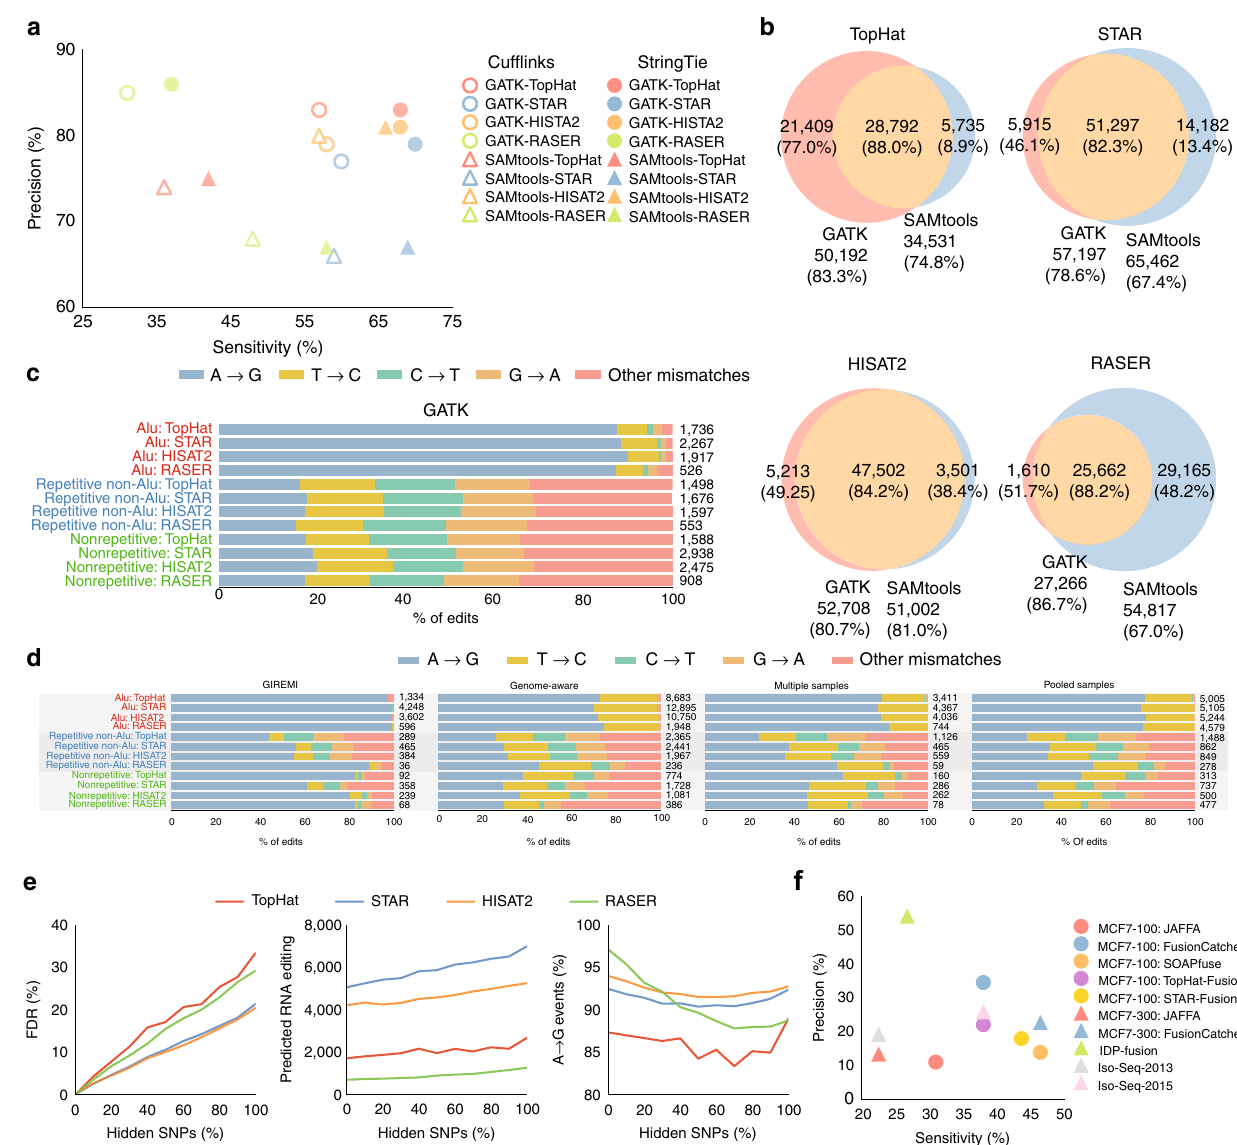
Fig. 7 Performance of different variant calling ( a – c ) RNA editing ( d , e ) and RNA fusion ( f ) detection approaches. a Accuracy of detecting NA12878 high- con fi dence calls in NIST gold standard. The analysis is restricted to the expressed exons identi fi ed by Cuf fl inks or StringTie. b Overlap between variants predicted by GATK and SAMtools. c Distribution of the predicted mismatch types by GATK that are missed in NIST HC calls (in StringTie ’ s expressed exons) in different genomic regions. d Distribution of RNA editing events detected in different genomic regions for NA12878. For multiple-samples scheme, fi nal editing sites include the rare variants in NA12878 that are supported by at least 3 out of 12 short-read samples in our analysis. For pooled-samples scheme, fi nal editing sites include the rare variants in NA12878 that are supported by at least 20 reads in the pooled alignment. e Measurement of RNA editing detection accuracy when some portion of SNPs are hidden from GIREMI. FDR represent proportion of predicted edits that are among high- con fi dence genomic variants in NA12878. f Performance of different RNA fusion detection schemes on MCF-7